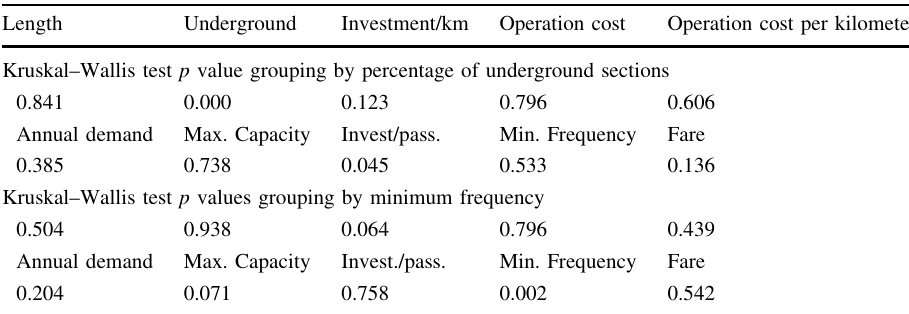
Table 3 Kruskal–Wallis test p values for differences between groups in each variable